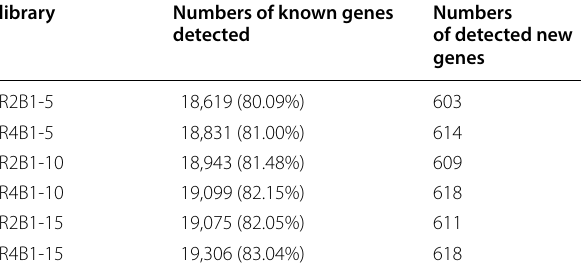
Table 2 Statistical results of expressed genes in different